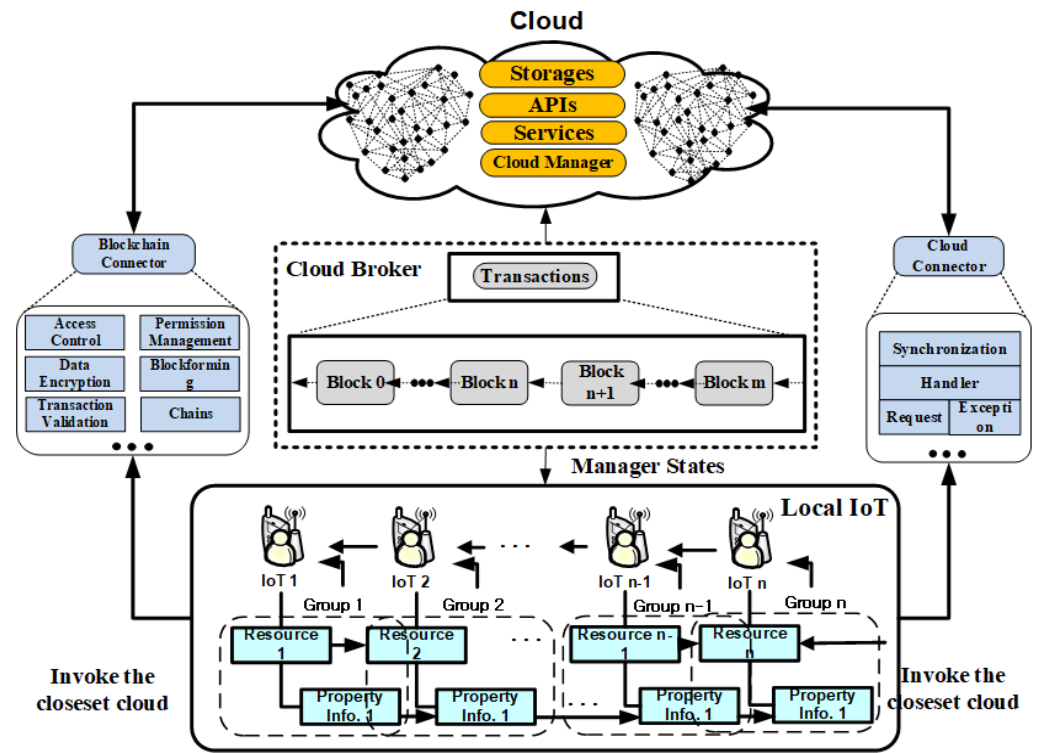
Figure 1. Blockchain-based Internet of Things (IoT) integrity verification data connection structure.